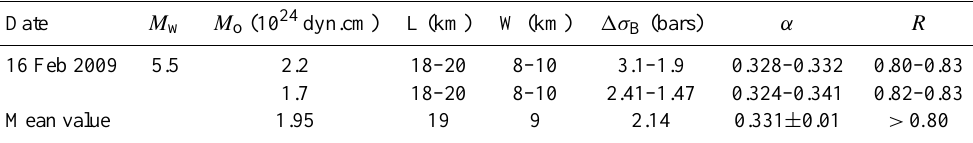
Table 2. The date, the magnitude M w and the seismic moment M o of event no. 17 along with the range of values in the dimensions of the aftershock area L and W, the corresponding calculated values for 1σ B , the critical exponent α and the associated correlation coefficient R . Mean values are given in the last row.